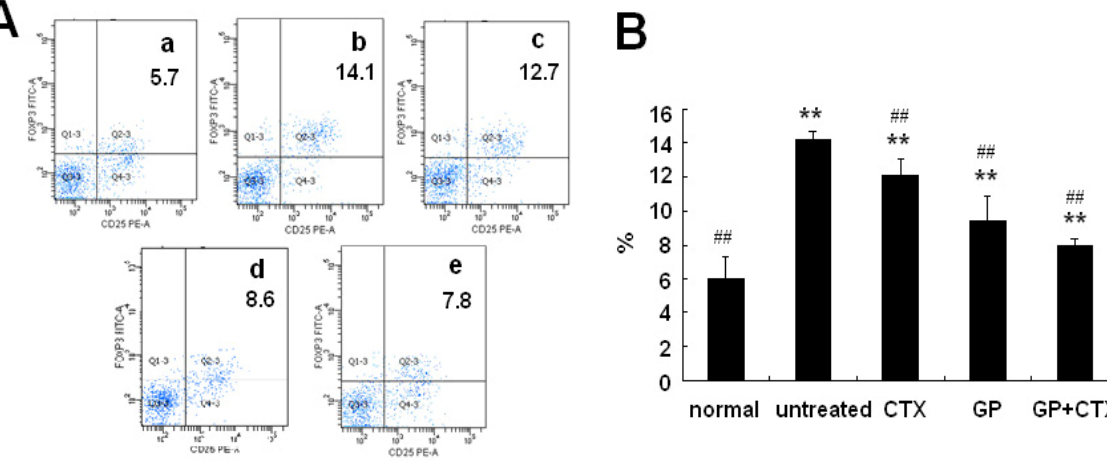
Figure 1. Effects of GP on the proportion of Treg cells in the spleen of tumor-bearing mice. ( A ) Flow cytometric results of the proportion of Treg cells in the spleen. a: Normal control group; b: untreated control group; c: CTX group; d: GP group; and e: GP+CTX group. ( B ) Analysis of the proportion of Treg cells in the spleen. The results are representative of three independent experiments. * P < 0.05, ** P < 0.01, vs. the normal